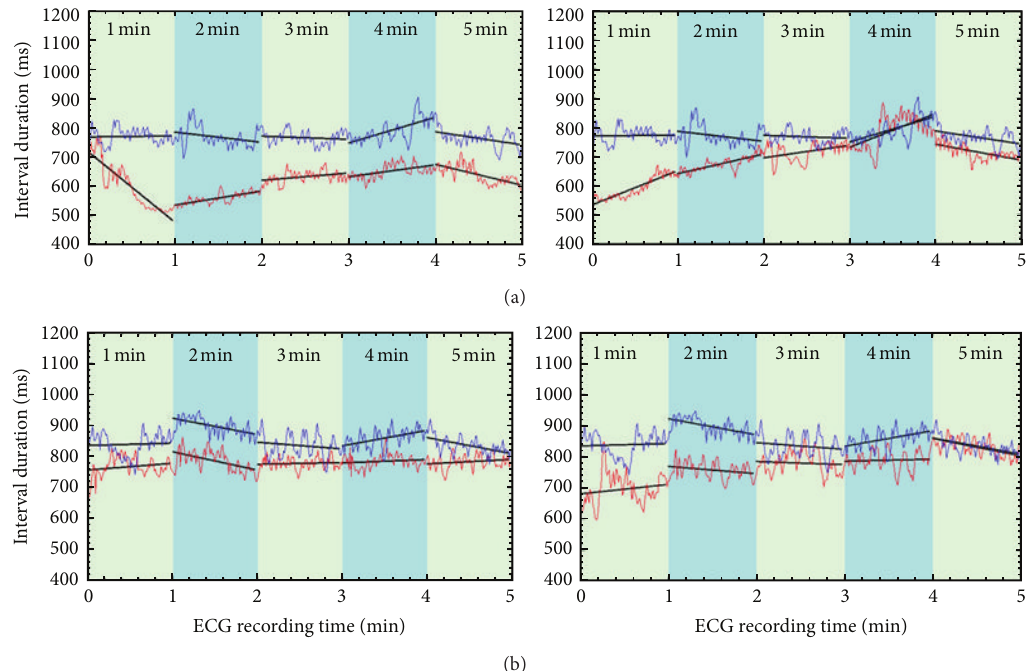
Figure 7: Illustrative examples on observed changes on the 𝑅𝑅 intervals for 2 subjects: subject 1 (a); subject 2 (b).